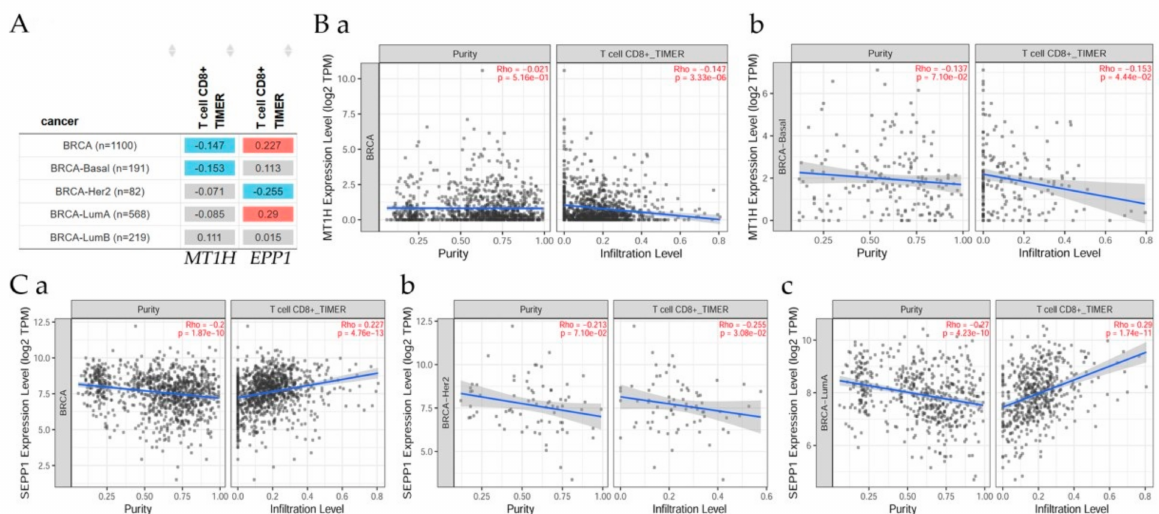
Figure 9. Correlations between gene expression and its immune infiltration levels in diverse breast cancer types. ( A ) The table explores the correlations between gene expression and T cell CD8+ immune infiltrates in BRCA patient types. These figures show the correlation between T cell CD8+ and ( B ) MT1H in ( a ) all BRCA, ( b ) BRCA-Basal, ( C ) SEPP1 in ( a ) all BRCA, ( b ) BRCA-Her2, and ( c )